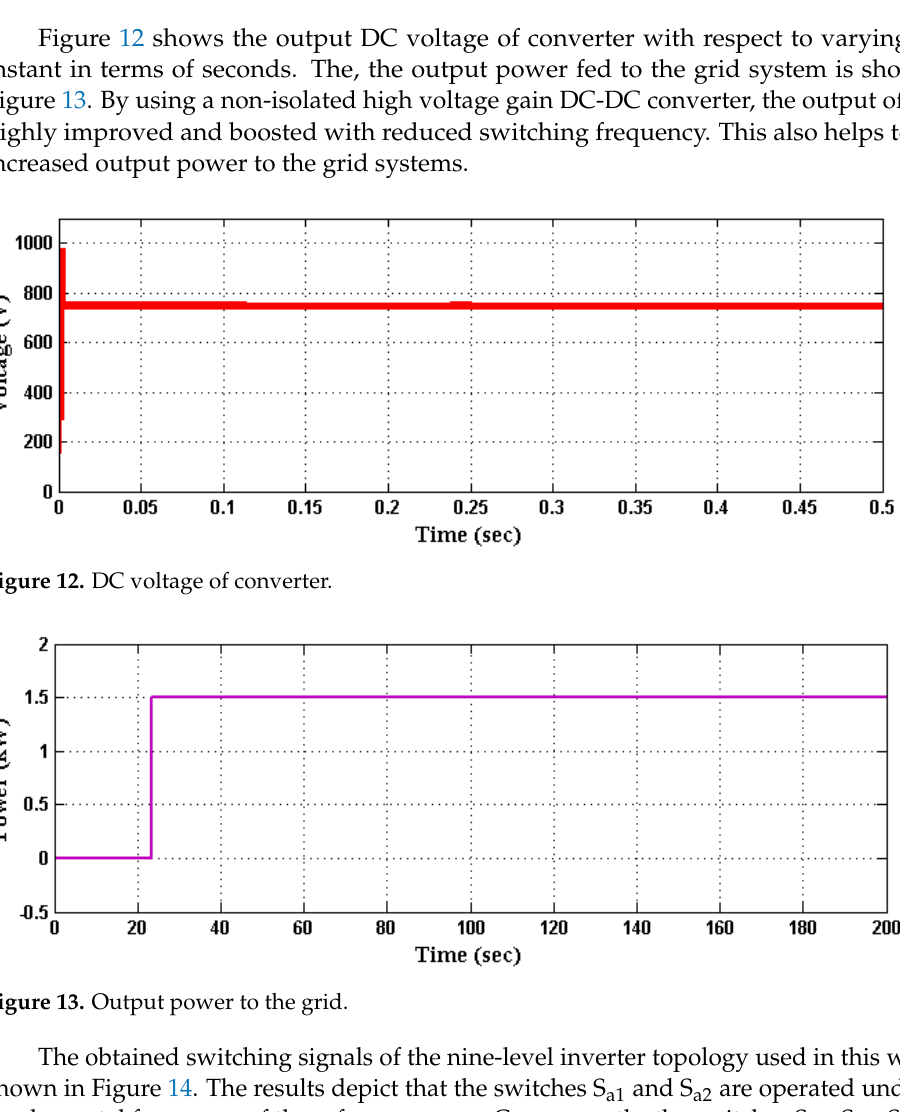
Figure 11. Output power with and without MPPT.